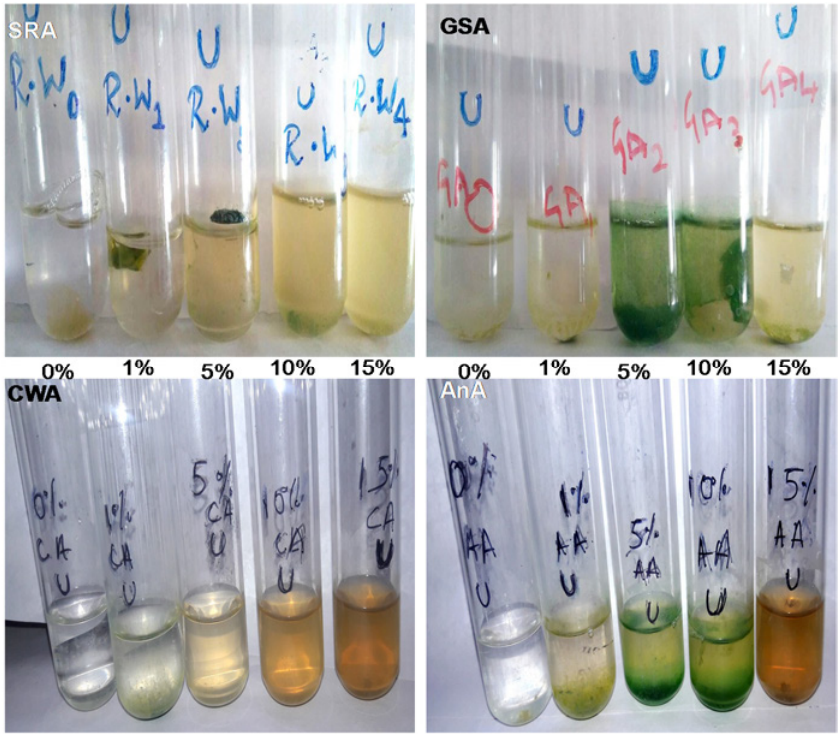
Fig. 1: Growth of microalgal isolates in cattle urine at varying concentration for 15 days under white light. Oscillatoria sp., SRA (stagnant rainwater algae); Chlorella sp., GSA (Goat shed algae); Oscillatoria sp., CWA (Coovam water algae); and Synechocystis sp., AnA (Anakaputur algae)